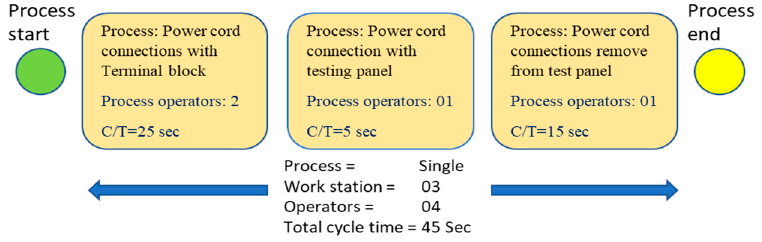
Figure 2. Outdoor unit testing process flow.